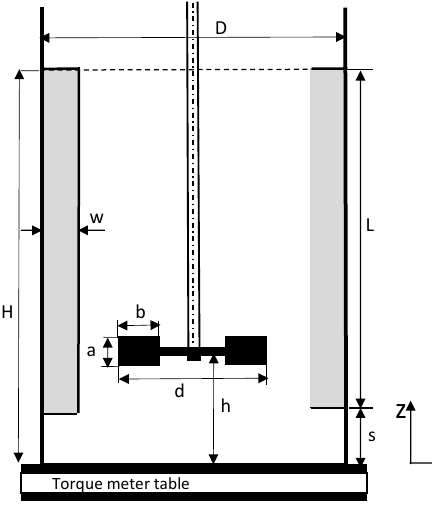
Fig. 1. Schematic diagram of the turbine and stirred